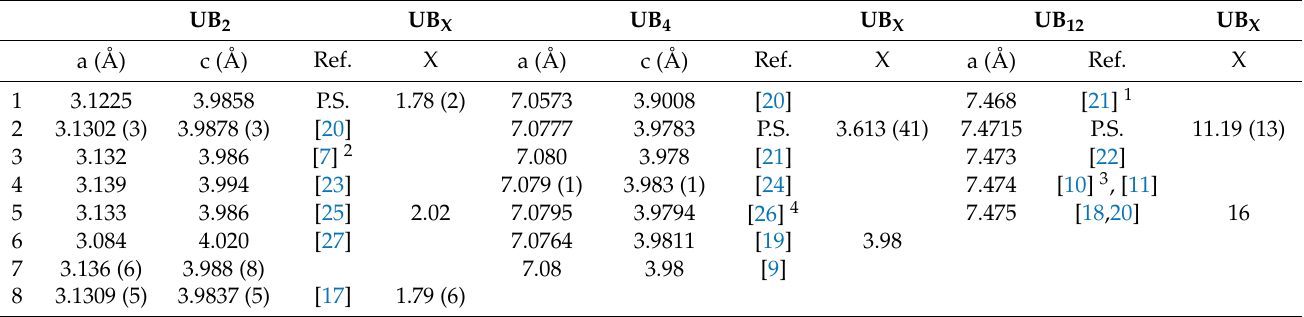
Table 3. Lattice parameters of UB 2 ± x , UB 4 − x , and UB 12 − x reported in the present study (P.S.) and from the